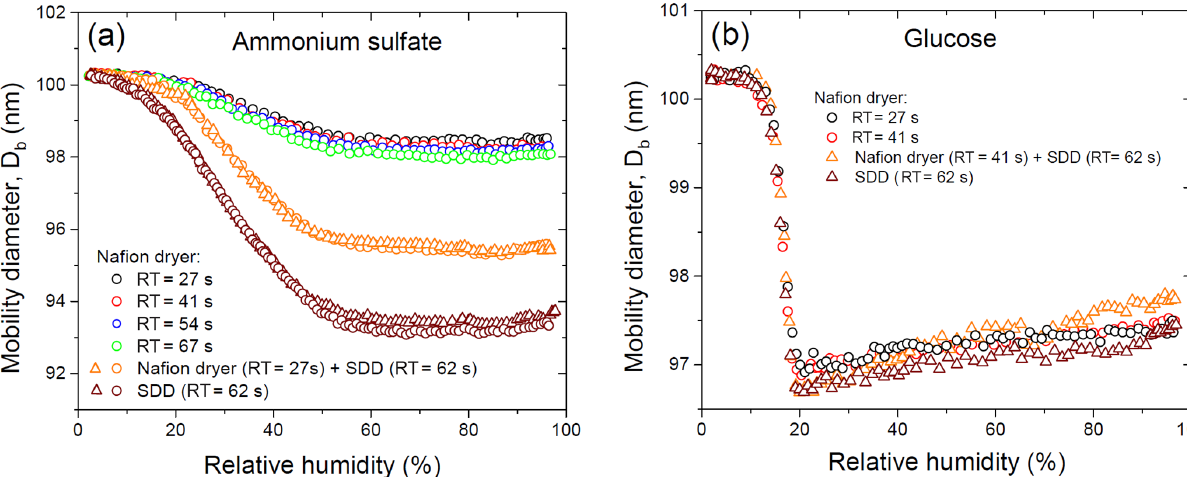
Figure 4. Mobility equivalent diameters of ammonium sulfate (a) and glucose (b) with the initial dry mobility equivalent diameter, D b, i = 100 . 3nm observed upon hydration and dehydration (H&D mode, RH2) depending on drying conditions. Different symbols are different experimental runs (a) . Table 1. Microstructural rearrangement parameters for pure ammonium sulfate and glucose aerosol particles obtained in the H&D experiment for different drying conditions (Fig. 4a, b). D b, i and D b, H&D , min are the mean plus or minus the standard deviation of 7–10 data points. The dynamic shape factor, χ , porosity, δ , and void fraction, f , together with propagated error, (cid:49)f , are calculated from Eqs. (3), (4), and (5) respectively. RT is the residence time. The χ and δ propagated uncertainty is better than ± 0 . 002. Type of dryer RT (s) D b, i (nm) D b, H&D , min (nm) χ δ f ± (cid:49)f (%) Ammonium sulfate MD-700 27 100 . 26 ± 0 .